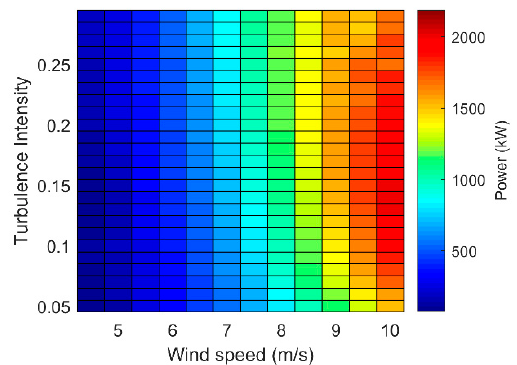
Figure 8. Power surface relating turbine power to wind speed and turbulence intensity.